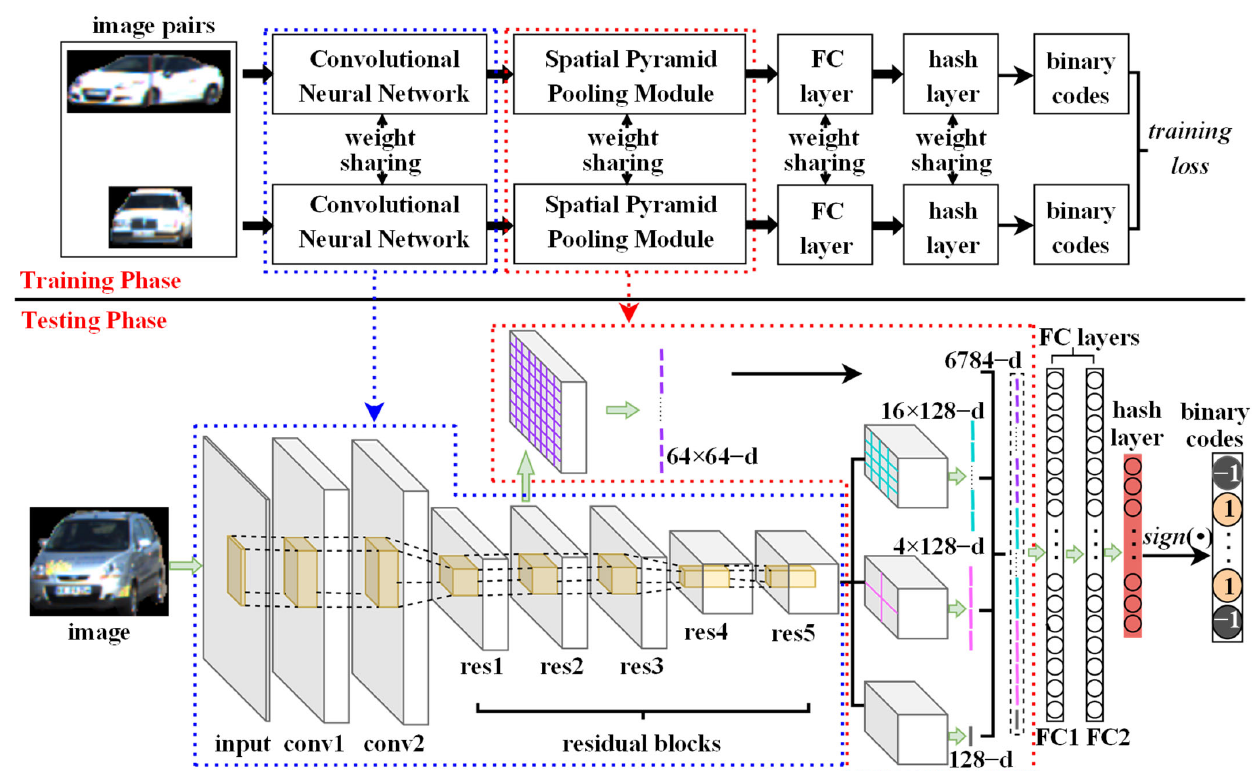
Figure 2. The architecture of the proposed spatial pyramid pooling hash network (SPPHNet).